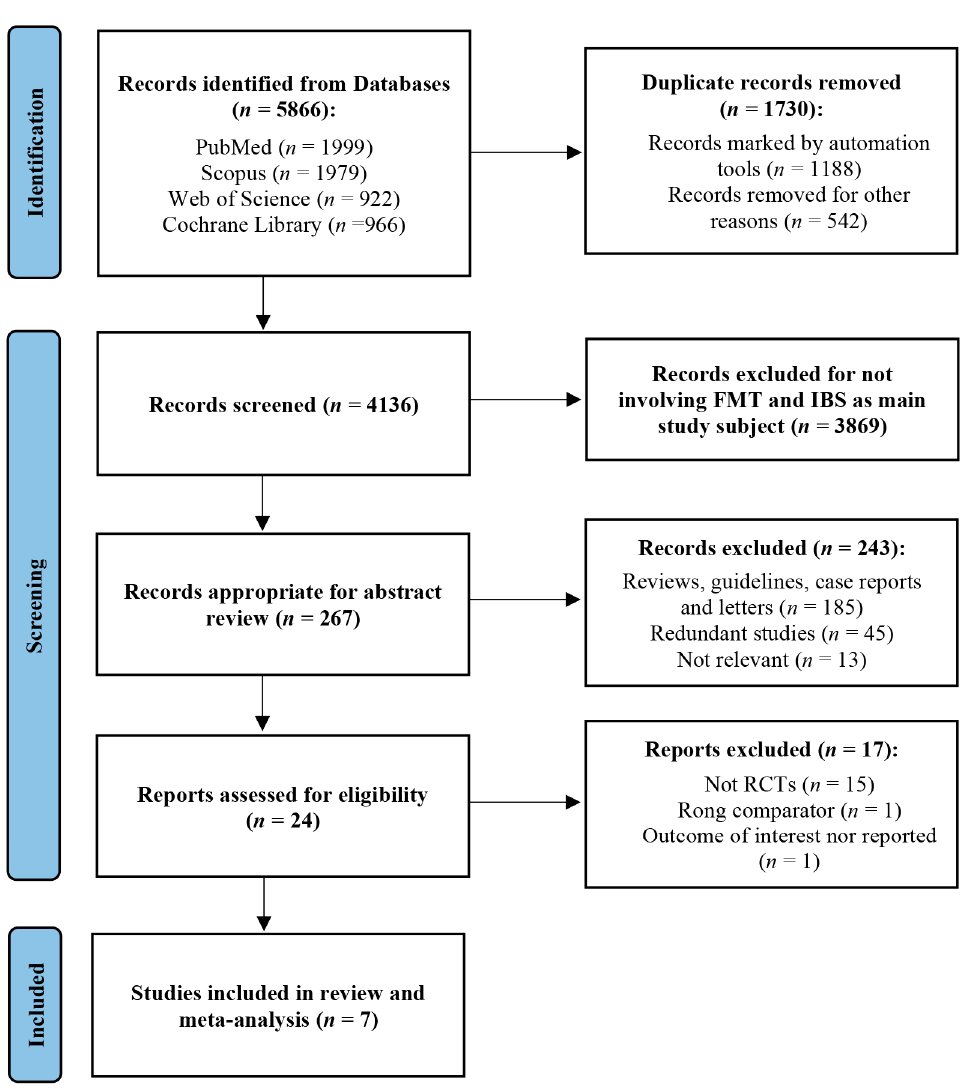
Figure 1. PRISMA study flow diagram describing the process of study selection.